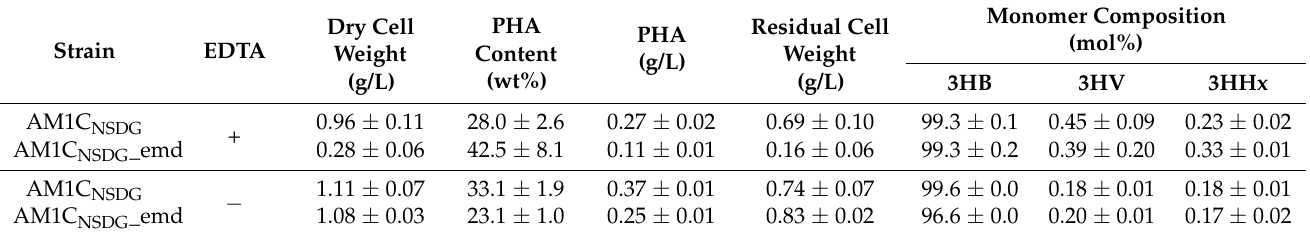
Table 2. P(3HB- co -3HV- co -3HHx) biosynthesis by M. extorquens emd -introducing strains from